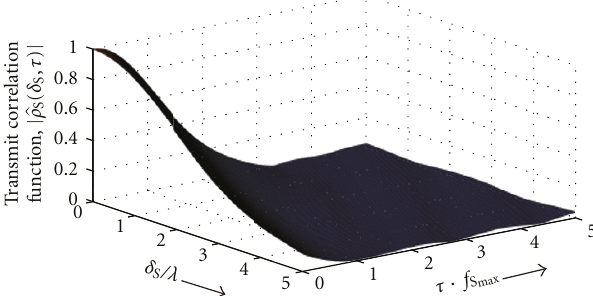
Figure 10: Absolute value of the source CF | (cid:22) ρ S ( δ S , τ ) | of the 2 × 2 × 2 MIMO M2M stochastic channel simulator designed by applying the MMEA with M = 40 (nonisotropic scattering, von Mises density = 60 ◦ and κ = 40). with φ (0) S S